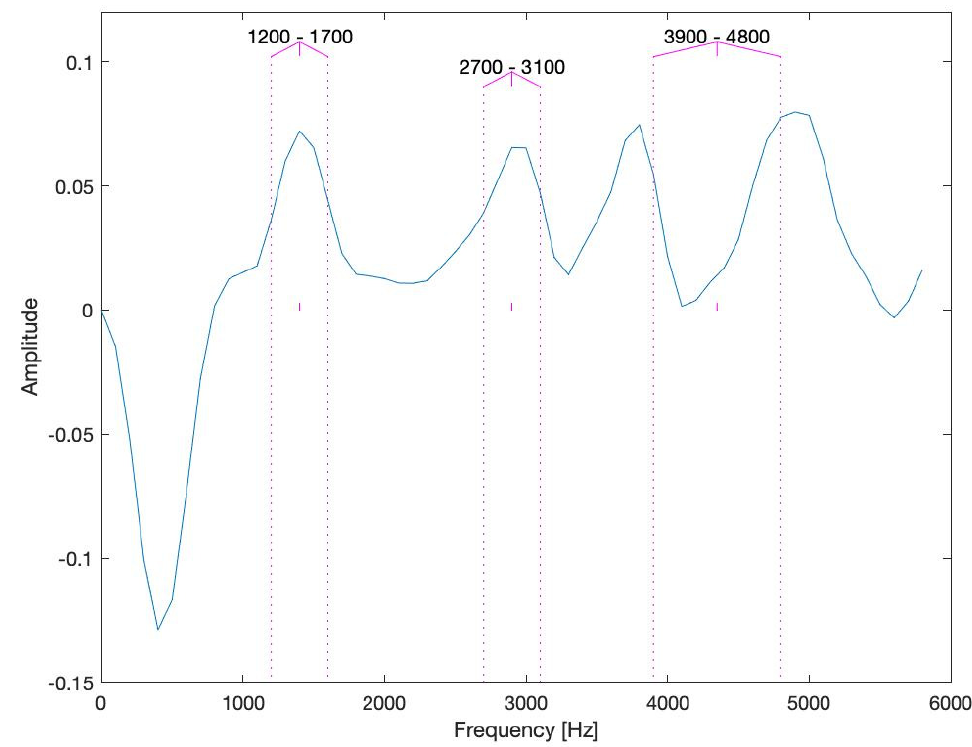
Figure 6. The difference between the modulus of the wavelet transforms of the CRS vibration signals recorded for fault-free and faulty gear conditions.